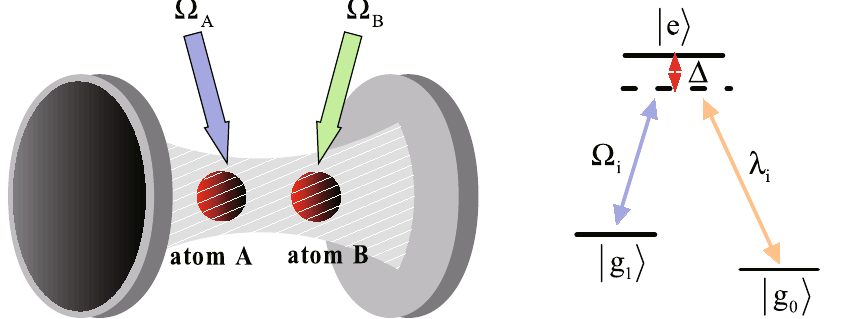
Figure 1. The cavity-atom combined system and the atomic level configuration for the original Hamiltonian. the transition ↔ e g is driven by classical field with time-dependent Rabi frequency Ω , the transition 1 ↔ e g is coupled to the cavity with coupling λ , and Δ is detuning 0